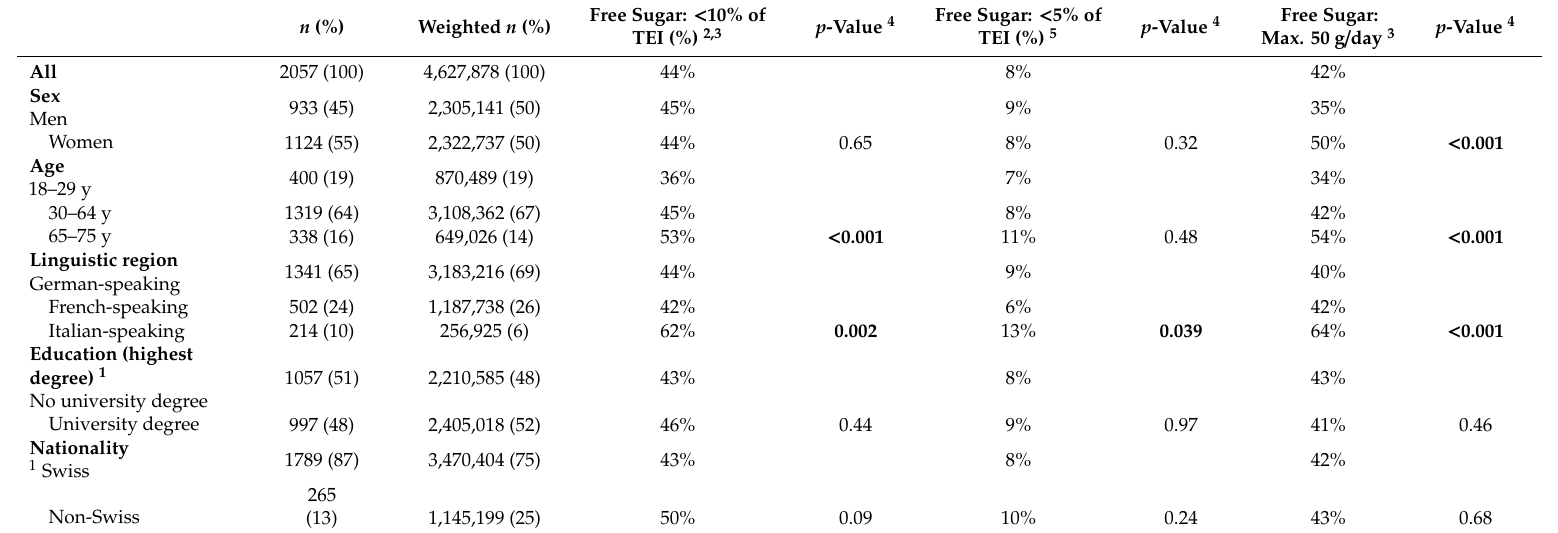
Table 4. Adherence to international and national